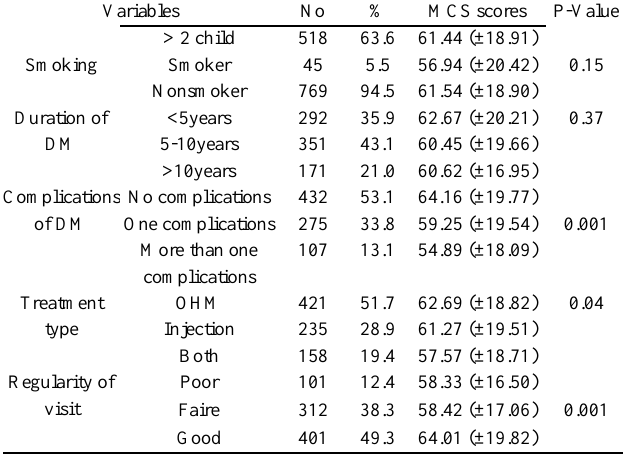
Table 5 : The difference between Physical Component Summary scores Mean (±SD) scores in obese and normal weight women according to study